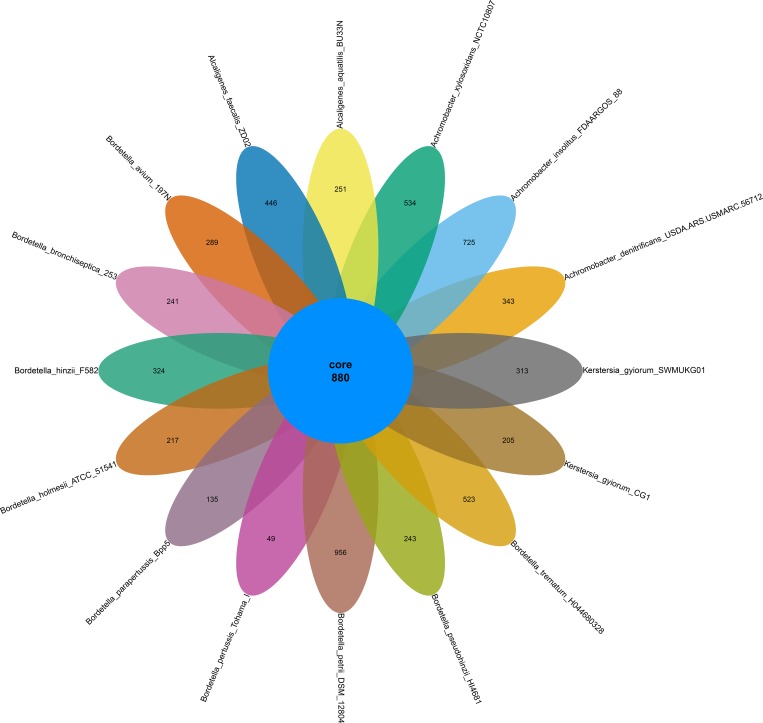
Venn diagram showing the gene conservation among the K. gyiorum SWMUKG01 and 15 other closely related bacteria.The number in the center of Venn diagram indicates the number of genes shared by all bacteria.